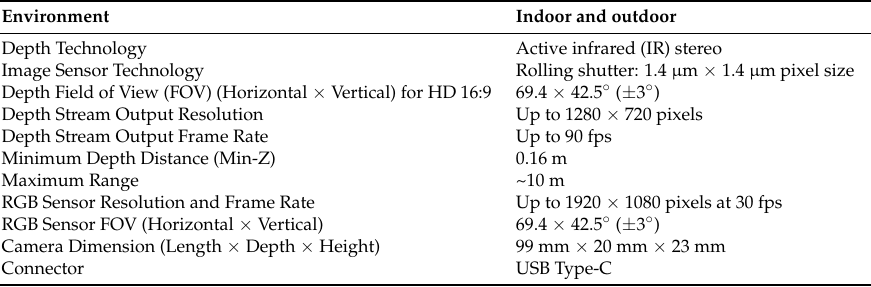
Table 1. The technical specifications of Intel RealSense D415.